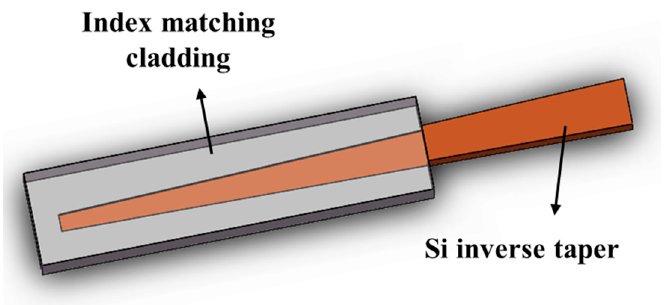
Figure 13. Sketch of silicon taper in index-matching cladding.